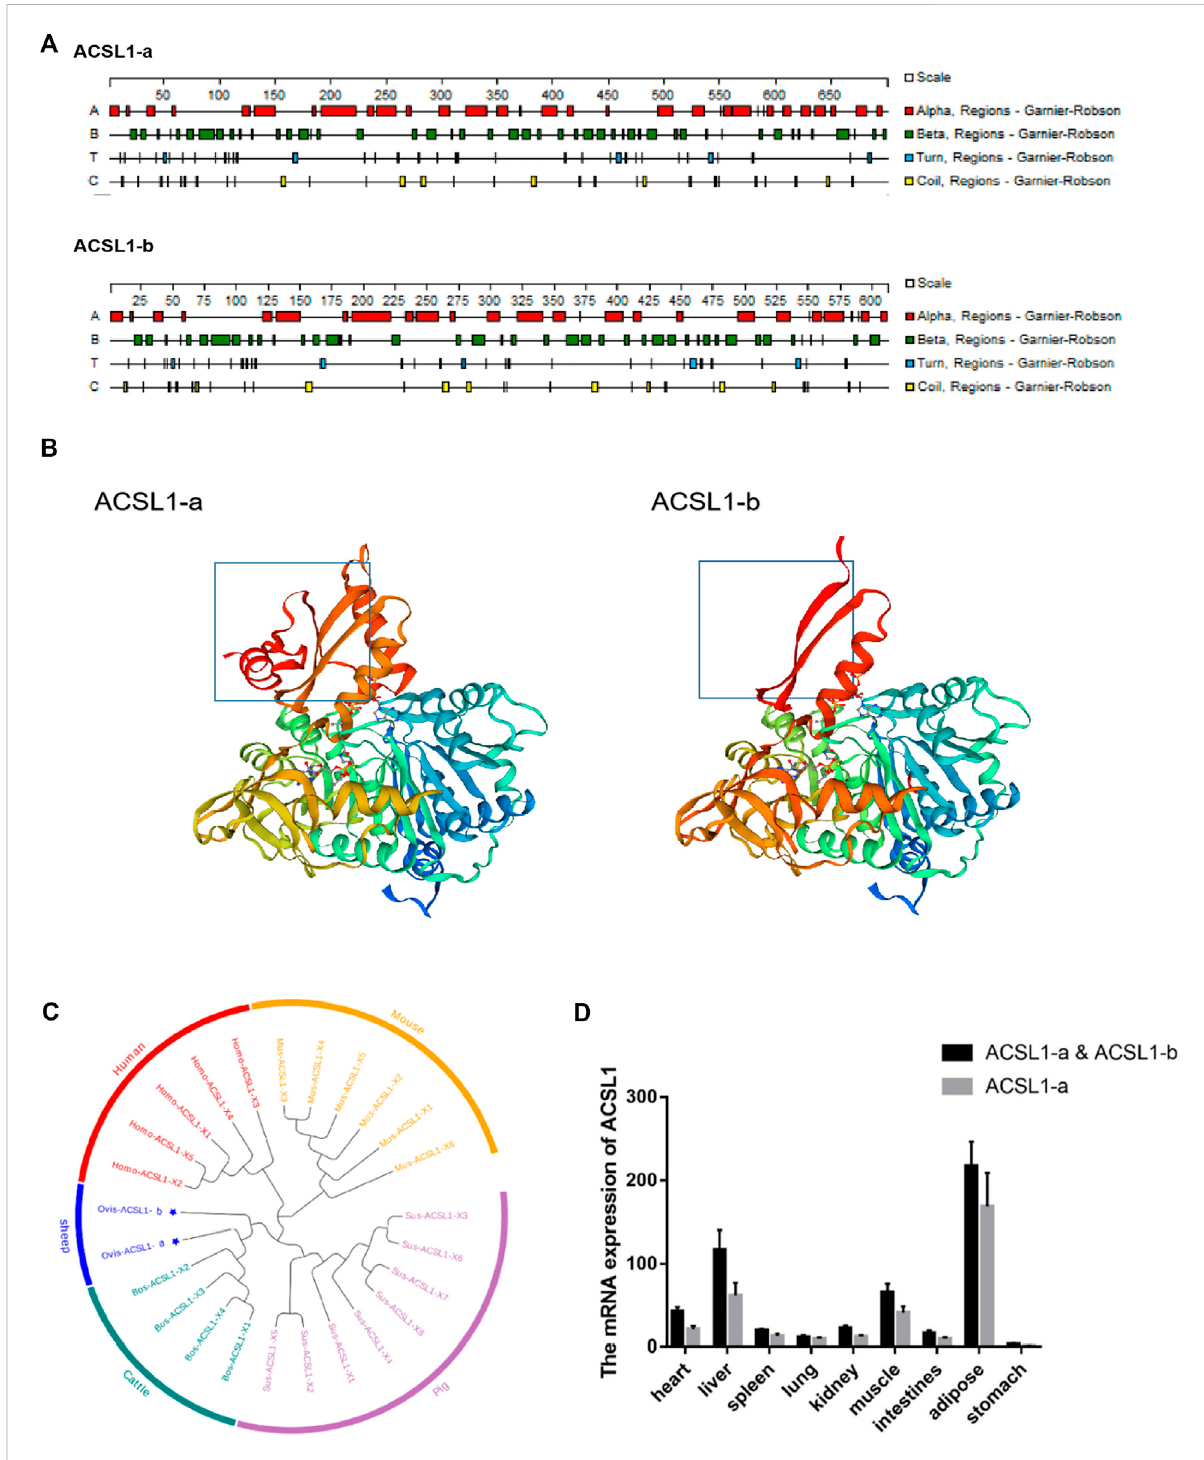
FIGURE 2 (A) Secondary structures of ACSL1-a and ACSL1-b proteins. (B) Tertiary structures of ACSL1-a and ACSL1-b proteins. (C) Phylogenetic tree depicting different ACSL1 transcripts. (D) Expression result of ACSL1 gene expression in various